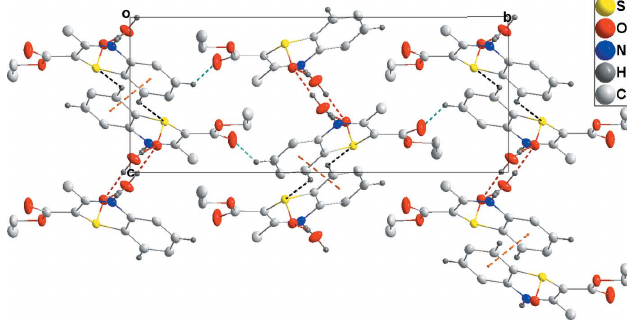
Figure 2 A portion of one chain viewed along the b -axis direction. O—H (cid:2)(cid:2)(cid:2) O, N— H (cid:2)(cid:2)(cid:2) O and C—H (cid:2)(cid:2)(cid:2) S hydrogen bonds are depicted, respectively, as red, dark-blue and black dashed lines. The offset (cid:2) -stacking interactions are shown as orange dashed lines.